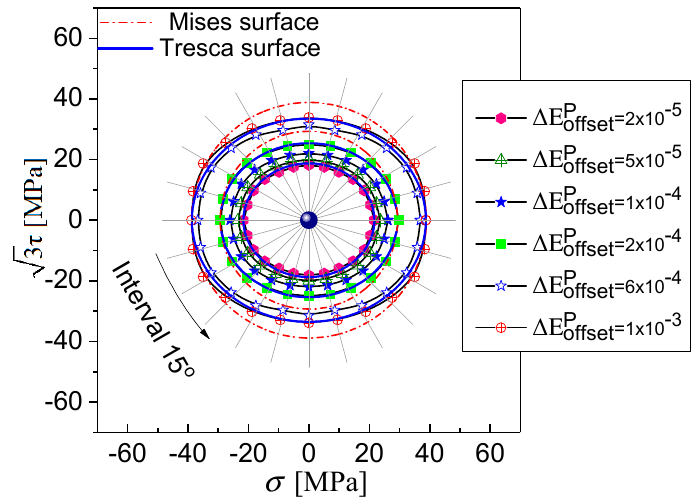
Figure 10. Initial yield surface by the GFEM simulation.